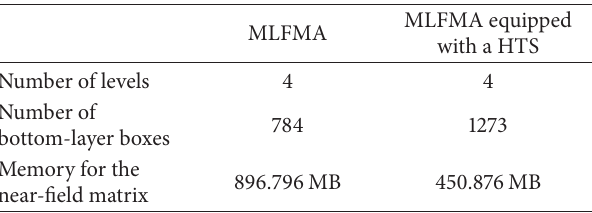
Table 1: Comparison between the two MLFMAs in Section 4.1.